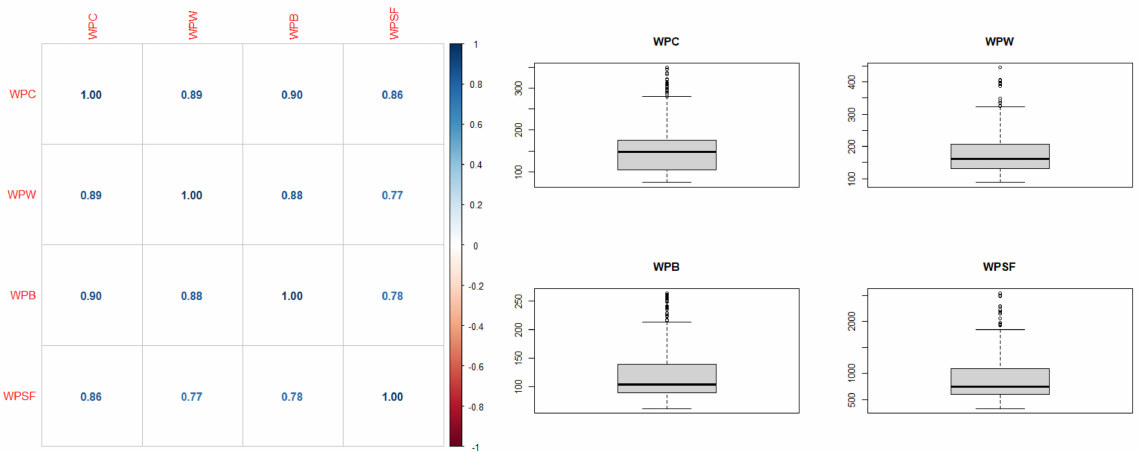
Figure A1. Correlation matrix and boxplots of the four agricultural commodities used in our work. Note: The figure indicates the correlation matrix based on the raw data of individual variables. The series represents the full-time period from 1 January 1990 to 1 August 2022. However, the boxplots were also based on raw data, and the plots were generated using the package “tidyverse” in R